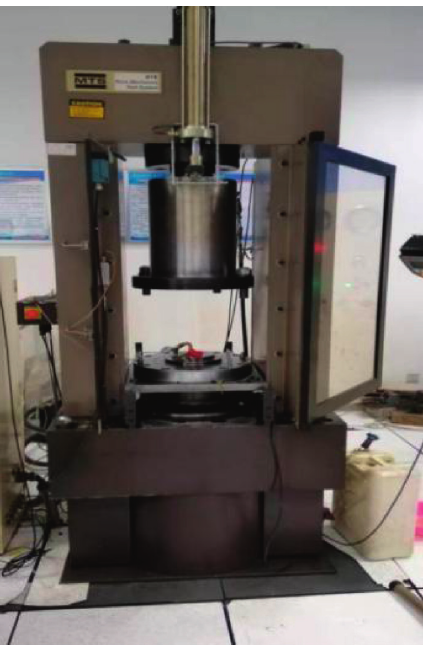
Figure 10: MTS rock mechanics comprehensive test